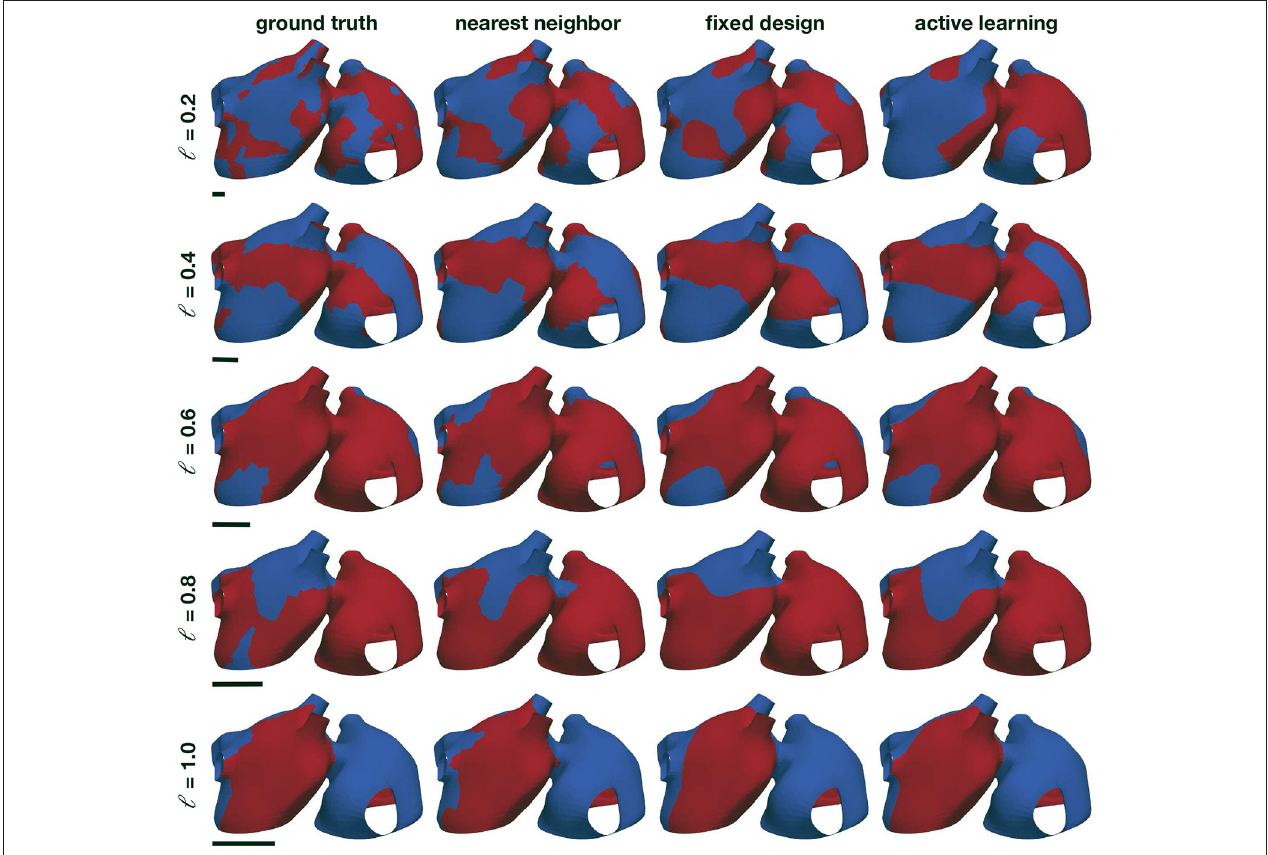
FIGURE 4 | Numerical assessment of the Gaussian process classifier. We create different random examples with different correlations lengths (first column) and train a nearest neighbor classifier (second column), a Gaussian process classifier trained with the same data-set as the nearest neighbor classifier (third column), and Gaussian process classifier that adaptively selects the training points through active learning (fourth column). The black bars represent the size of the length scale relative to the atrial